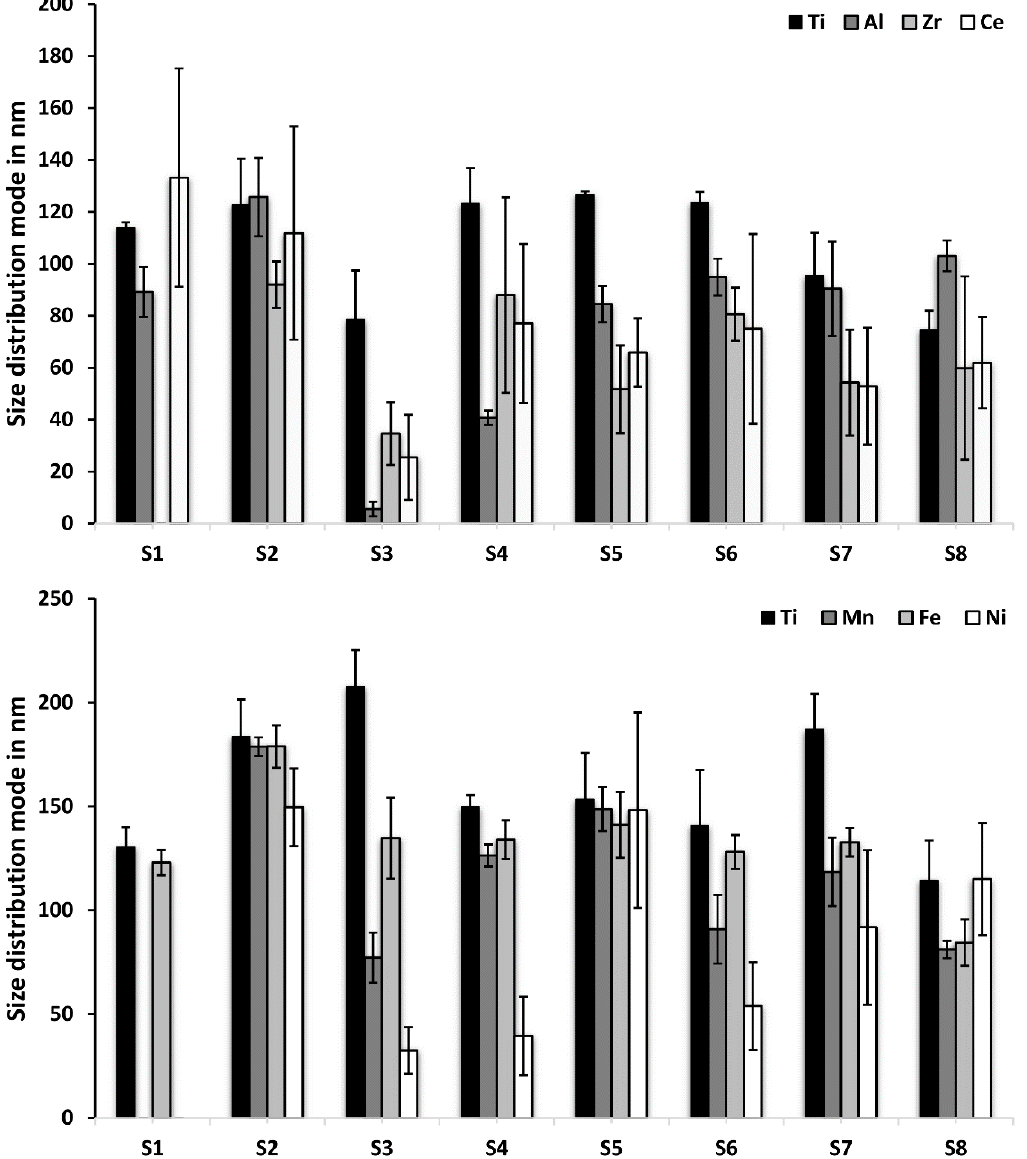
Figure 8. Particle size distribution modes determined using HDC-ICP-MS for the colloidal extracts of the eight investigated soils. The distribution modes were measured in two runs, the first run after the extraction for the isotopes 47 Ti, 27 Al, 90 Zr, and 140 Ce (upper graph) and the second run one day later for the isotopes 47 Ti, 56 Fe, 55 Mn, and 60 Ni. The length of the error bars is equal to two times the standard deviation determined for three sample replicates.